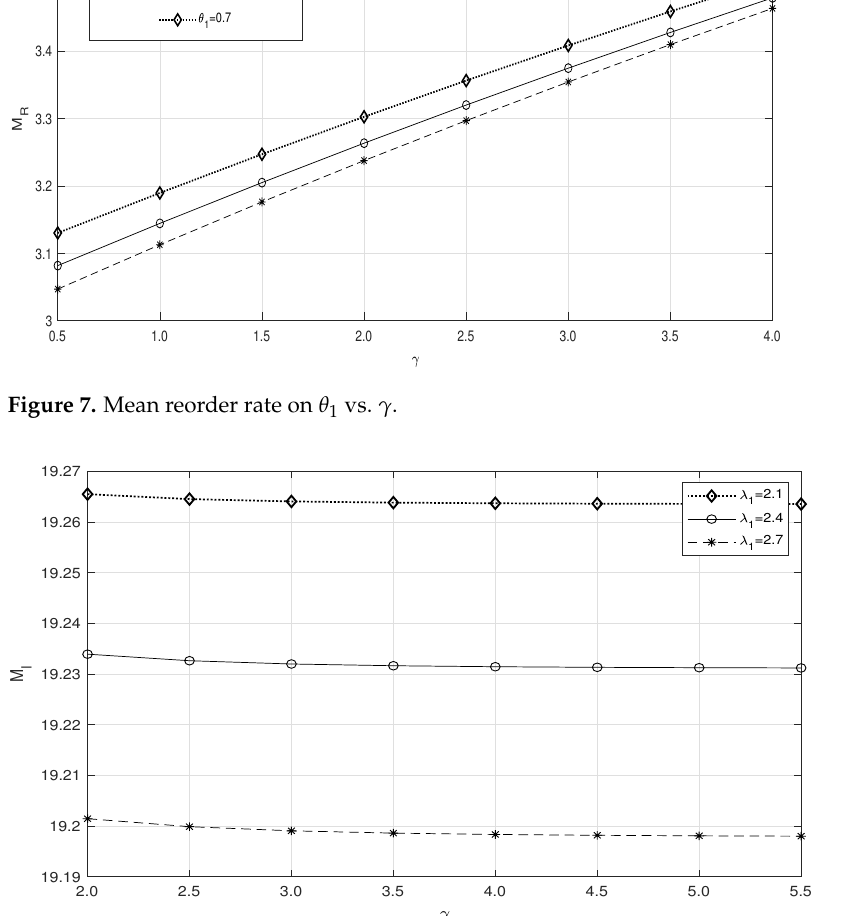
Figure 8. Mean number of items in the inventory on λ 1 vs. γ .